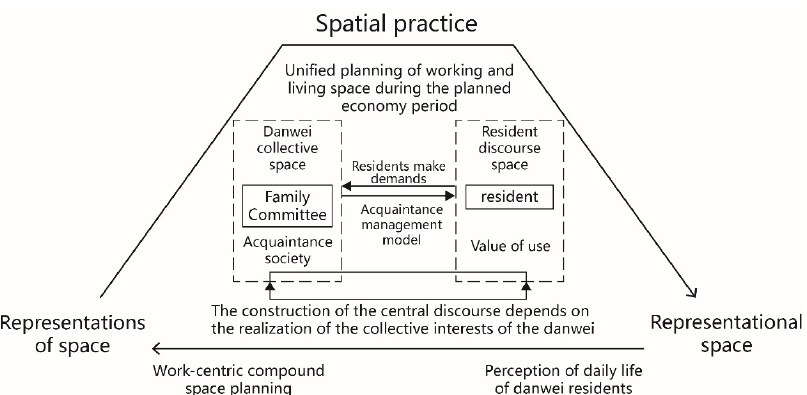
Figure 2. Homogeneous absolute space production path (source: self-drawn by one of the